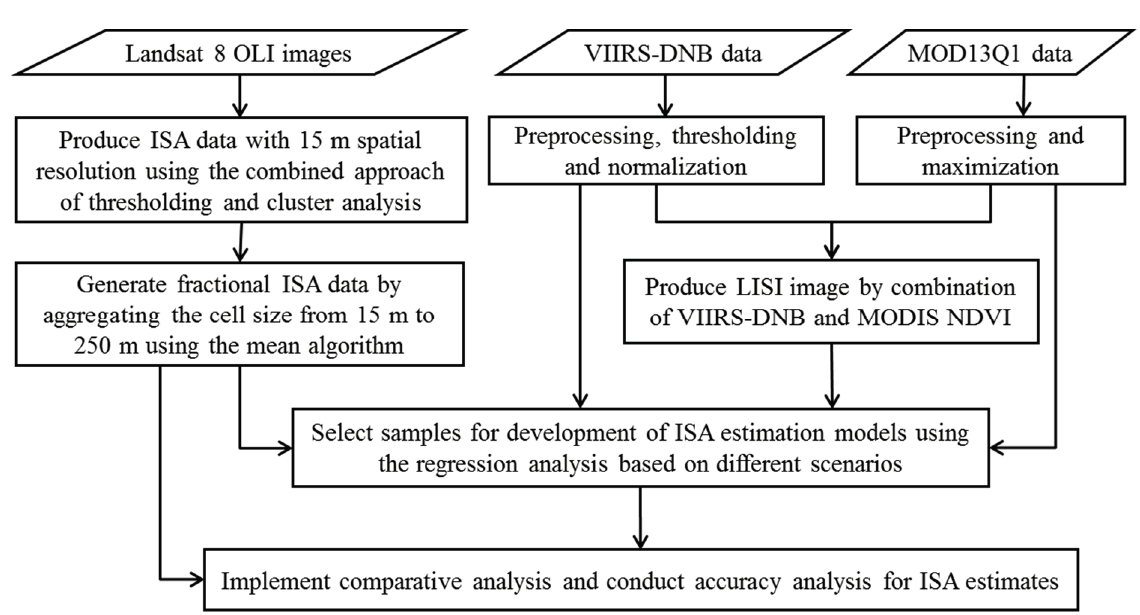
Figure 2. Framework of mapping ISA distribution using the Large-scale Impervious Surface Index